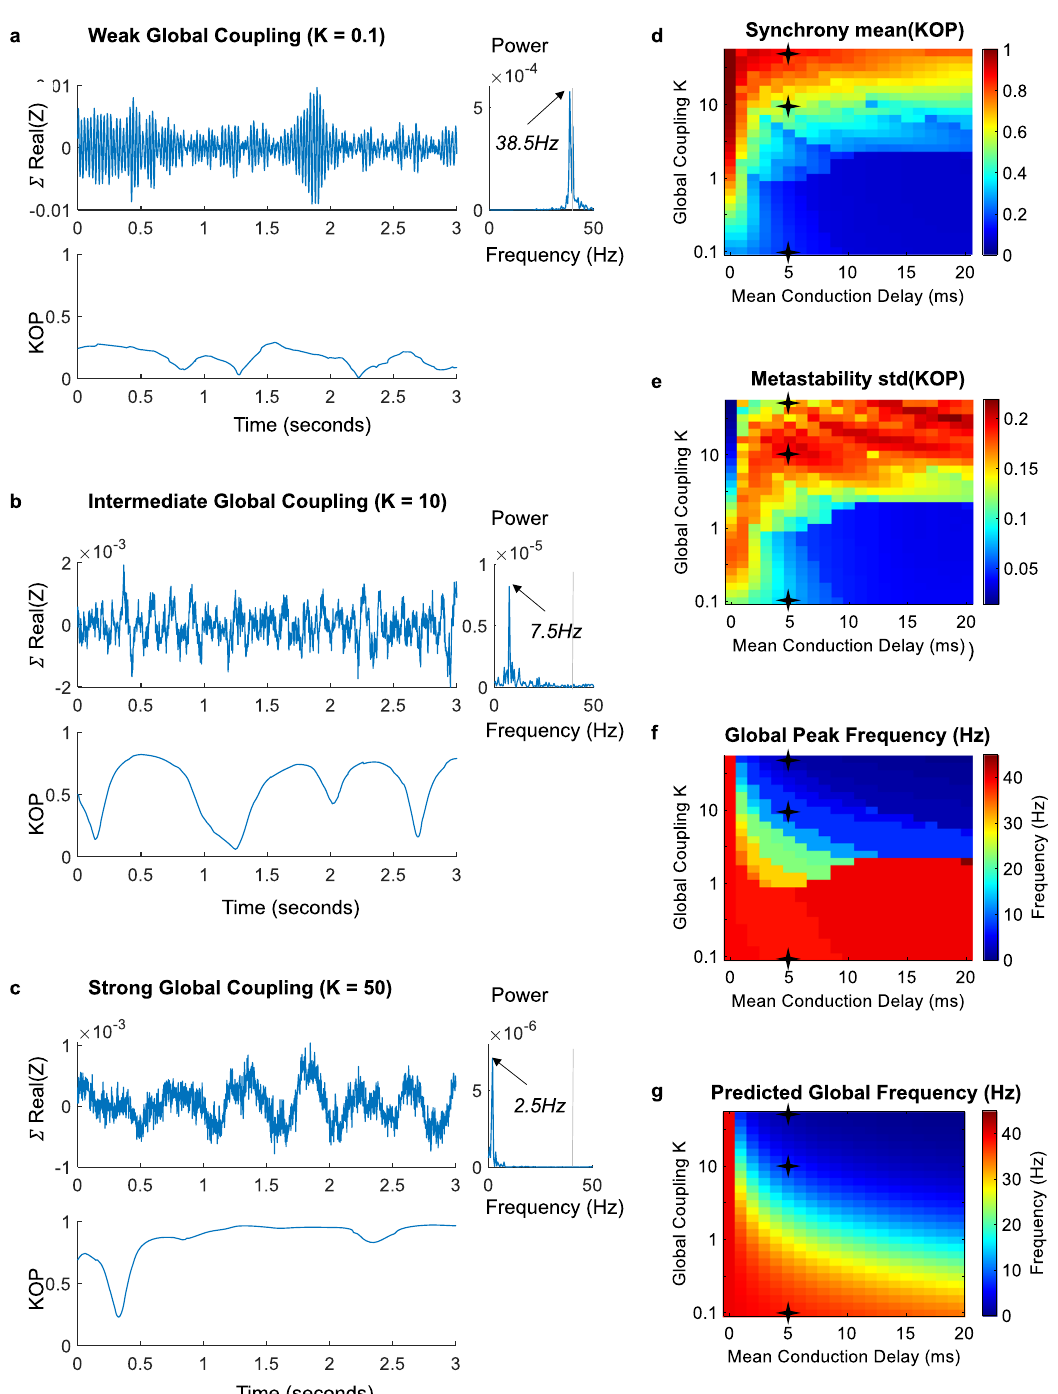
Fig. 2 Collective oscillations emerge at reduced frequencies from time-delayed synchronization. The system of N = 90 coupled oscillators, Z , was simulated for 50 s in the presence of white noise, varying only two global parameters: the Global Coupling K (increasing exponentially to better capture the effect of delays) and the conduction speed, which scales the Mean Conduction Delay. a – c To illustrate the effect of the coupling strength in the frequency Z N = 90 is reported for three levels of global coupling, keeping the same mean conduction of synchronization, the collective signal given by ∑ N n ¼ n . with 1 delay of 5 milliseconds. The corresponding power spectra are reported on the right of each plot, and the Kuramoto Order Parameter (KOP) is reported below. For weak coupling ( a ) the simulated signal exhibits oscillations peaking close to the node ’ s natural frequency. For intermediate coupling ( b ), weakly stable synchronization generates transient oscillations at reduced frequencies. For strong coupling ( c ), global synchronization becomes more stable, and all units are entrained in a collective oscillation at a reduced frequency. For intermediate coupling, fl uctuations in the order parameter are indicative of metastability. d – g For each simulation across the parameters explored, we report: ( d ) the mean of the KOP (referred to as Synchrony); ( e ) the standard deviation of the KOP (referred to as Metastability 87 ); ( f ) the peak frequency of the simulated collective signal; ( g ) the synchronization frequency predicted analytically, showing agreement with simulation results for suf fi cient